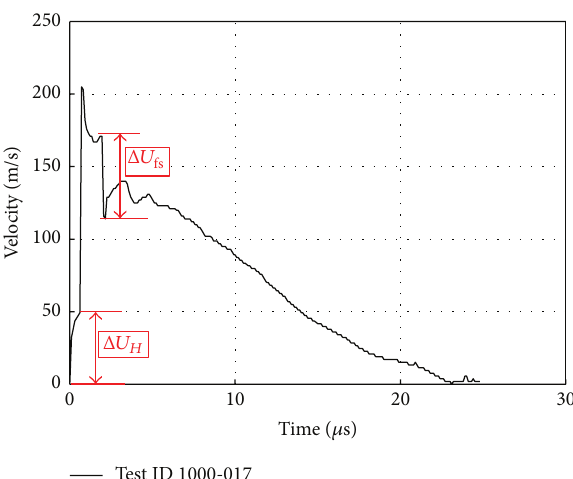
Figure 7: HEL and spall strength calculation for typical